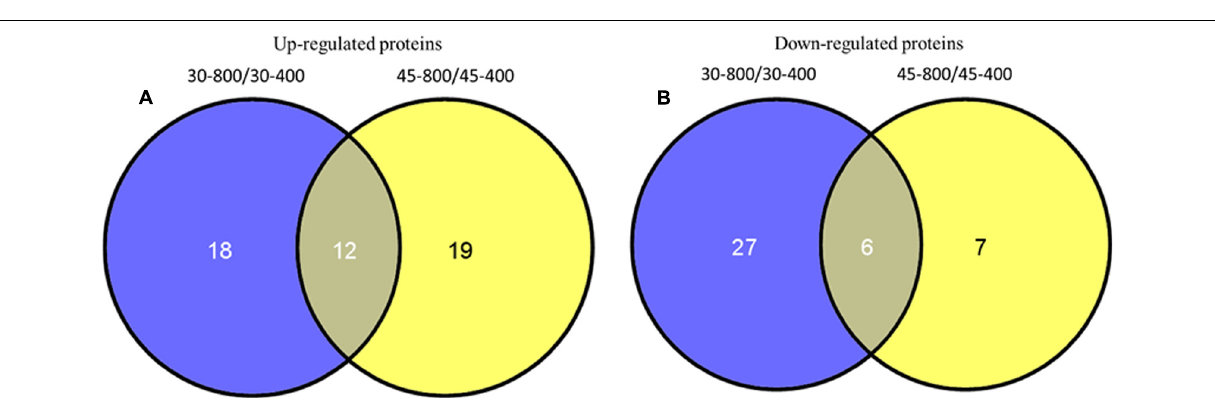
FIGURE 11 | Cluster analysis from gene ontology (GO) analysis of differentially expressed proteins in response to different CO 2 concentrations under normal temperature (A) and heat stress (B) in leaves of bermudagrass. The treatments symbols are 30 and 45 for normal temperature control and heat stress and 400 and 800 for ambient CO 2 and elevated CO 2 concentrations, respectively. BP, biological process; MF, molecular function; CC, cellular component.